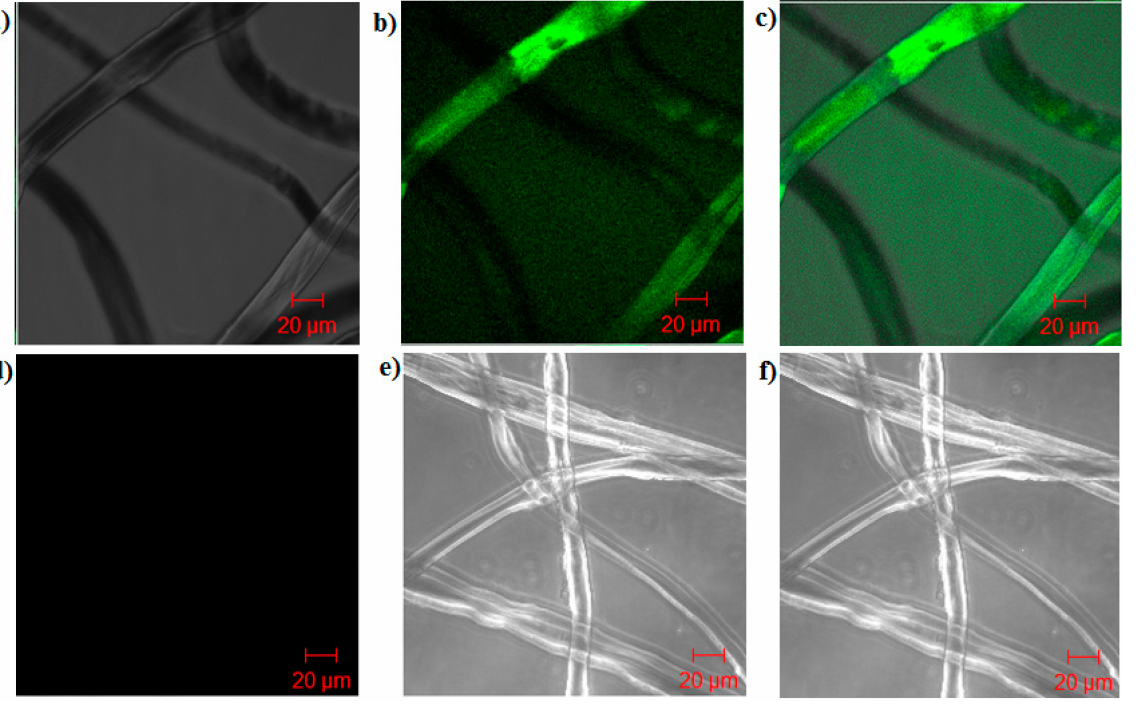
Figure 2. Confocal microscopy of Q fibers: ( a ) bright field, ( b ) fluorescence and ( c ) merged images of BSA labeled with Alexa Fluor 488 (green dye); and ( d ) bright field, ( e ) fluorescence and ( f ) merged images of non-labeled BSA at 488